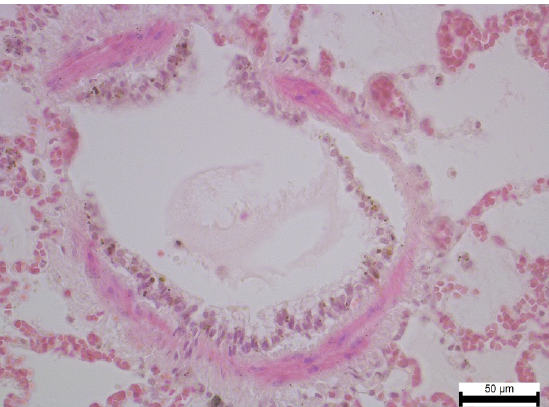
Fig. 14 B. Lungs. Transudate in the lumen of the bronchus. Disorders of the bronchus. Hematoxylin and eosin. EP 10, lens